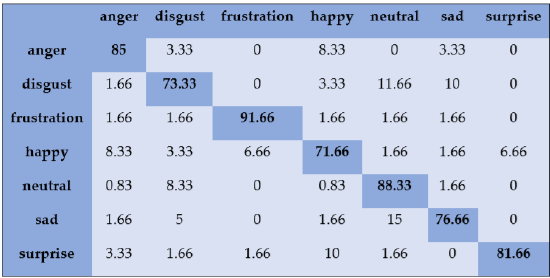
Figure 3. Confusion matrix of SAVEE dataset for speaker-dependent